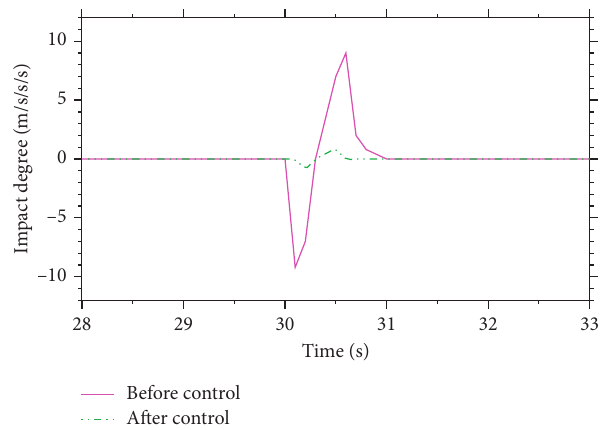
Figure 12: Comparison of impact degree before and after control. Table 4: Comparison before and after coordinated control. Before control After control Improvement percentage Maximum torque deviation (Nm)